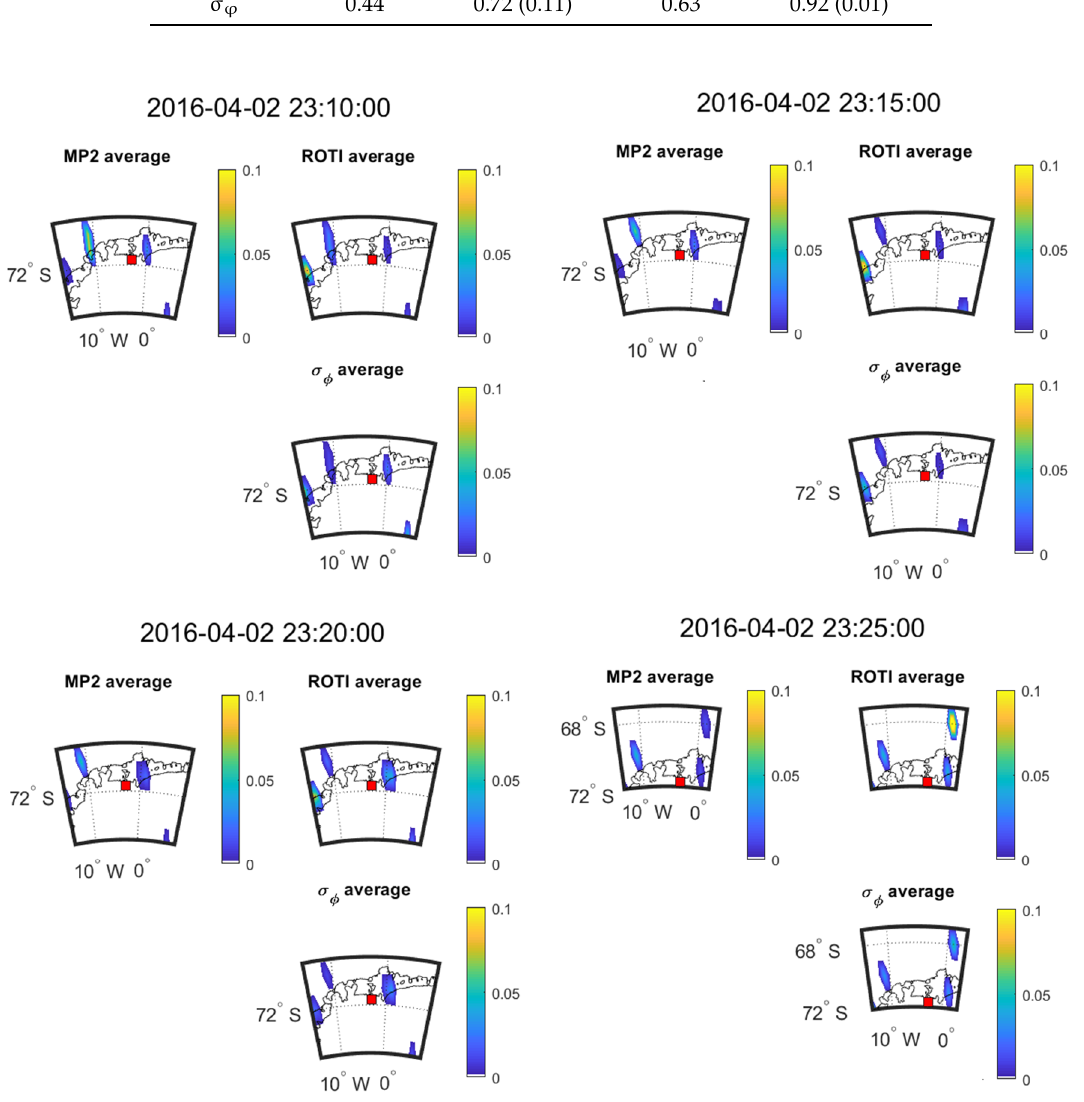
Figure 17. Consecutive 5 min means over 20 min at SNA0P station on 2 April 2016.